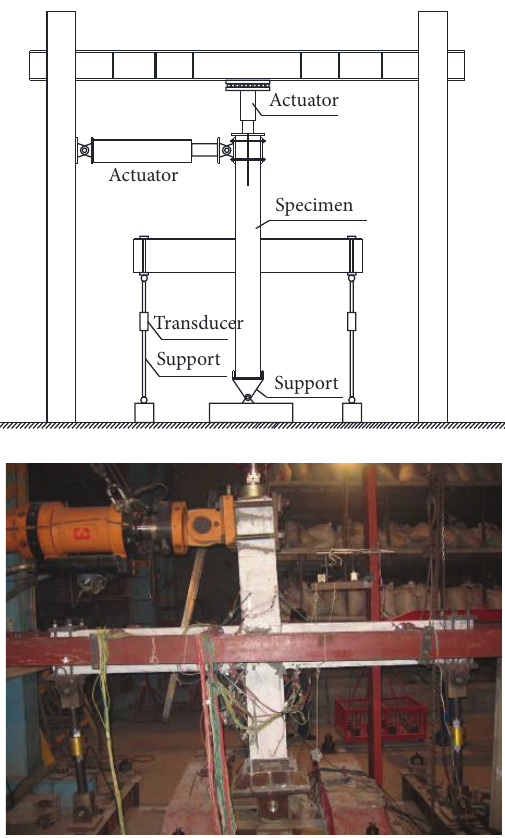
Figure 3: Test set-up and loading